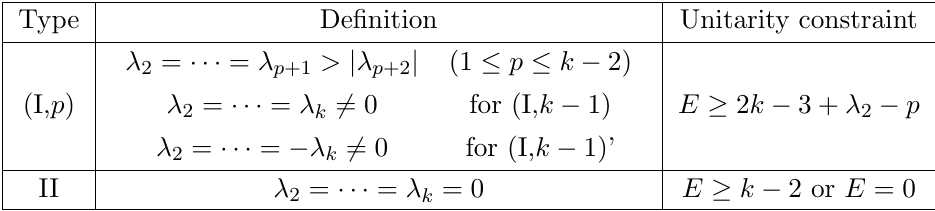
Table 5 . Unitarity conditions for so (2 ; 2 k (cid:0) 2). Here (cid:21) 2 (cid:21) (cid:1) (cid:1) (cid:1) (cid:21) (cid:21) k (cid:0) 1 (cid:21) j (cid:21) k j , all the di(cid:11)erences (cid:21) i (cid:0) (cid:21) i +1 2 Z for i = 2 ; : : : ; k (cid:0) 1 and 2 (cid:21) k 2 Z . We use interchangeably the notation E = (cid:0) (cid:21) 1